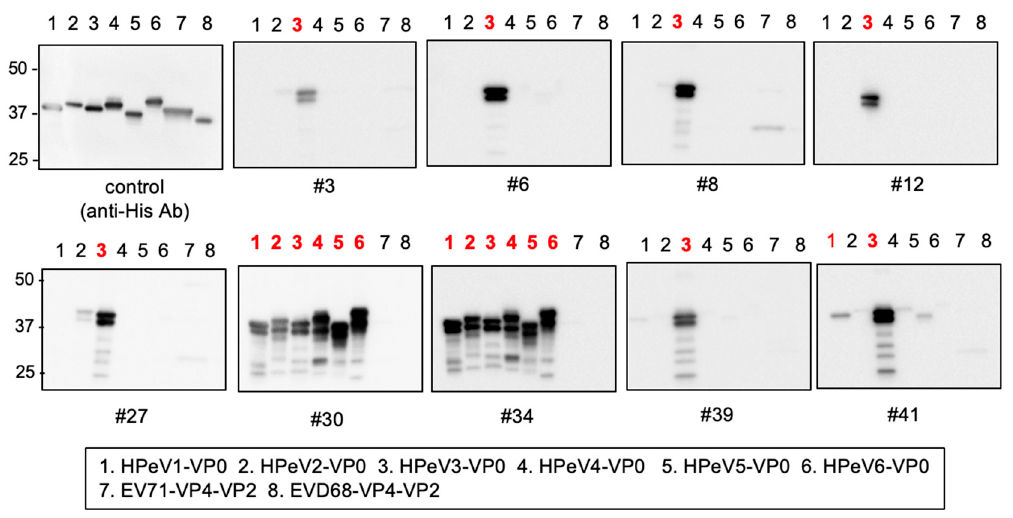
Figure 3. Cross-reactivity of anti- HPeV3-VP0 mAbs. Cross-reactivity of selected mAbs to related HPeVs. His-tagged VP0 proteins of HPeVs were synthesized by a wheat germ cell-free system and the reactivity of mAbs was then assessed by immunoblotting analysis. The numbers associated with lanes showing positive bands are highlighted in red.